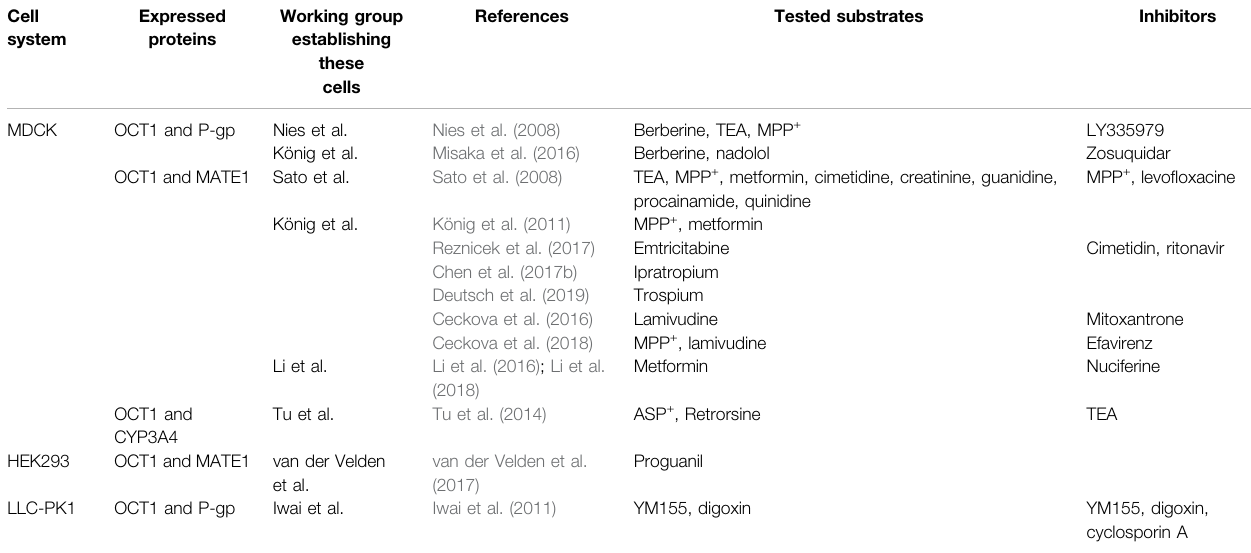
TABLE 2 | OCT1 expressing, double-transfectant cell lines and investigated substrates and